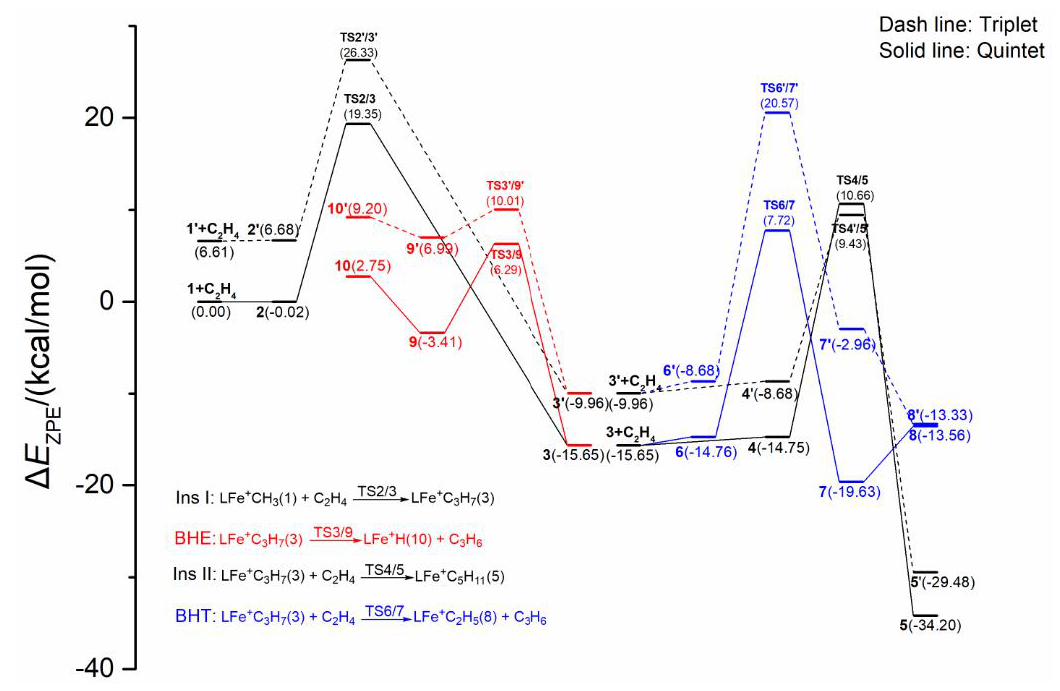
Figure 5. Energy profiles (kcal / mol) for the first and second ethylene coordination and insertion (black), β -H transfer ( BHT , in blue) and β -H elimination ( BHE , in red) catalyzed by the cationic iron complex in triplet (dash line) and quintet (solid line) spin states. The energies are relative zero-point energies with respect to the reactants: LFeCH 3 ( + ) ( 1 )(quintet state) and C 2 H 4 . The number n corresponds to Fe( + )- n , the TS m / n refers to the transition state between the two intermediates Fe( + )- m and Fe( + )- n .